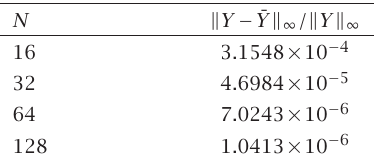
Table 4.2 . The numerical results for Example